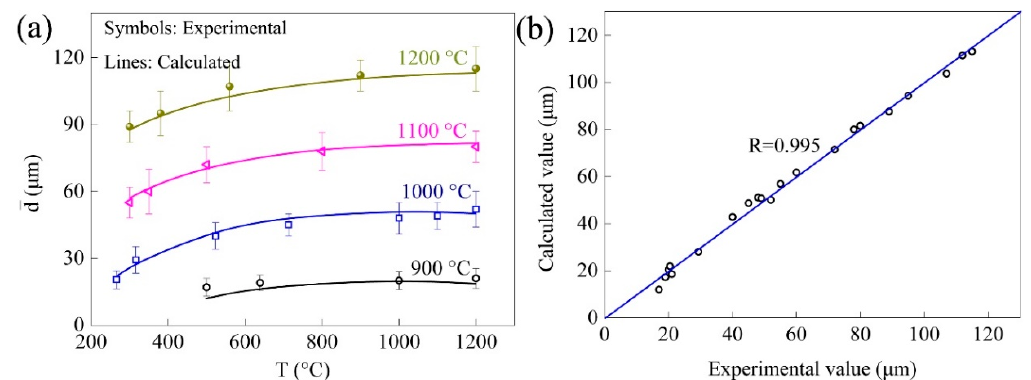
Figure 13. Comparison of the calculated and experimental grain size. It showed ( a ) comparison of calculated and experimental grain size; and ( b ) a scatter plot drawn from calculated and experimental grain size.